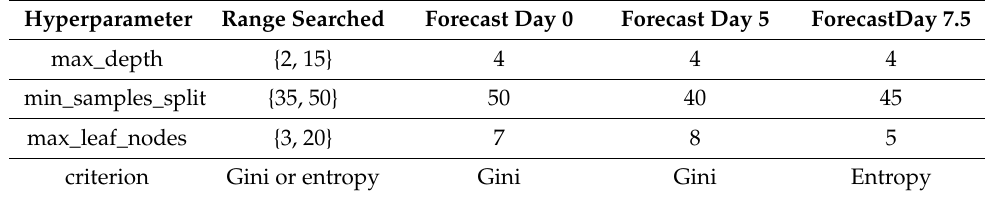
Table 4. Tuning of the hyperparameters.